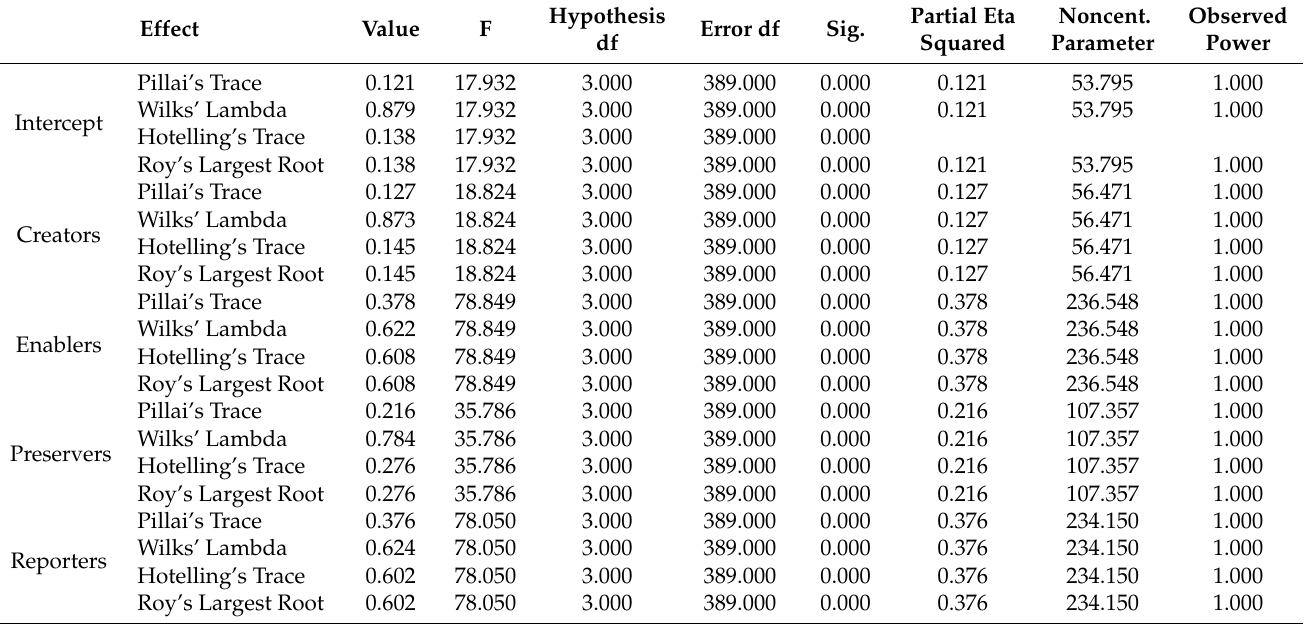
Table 4. Multivariate tests.